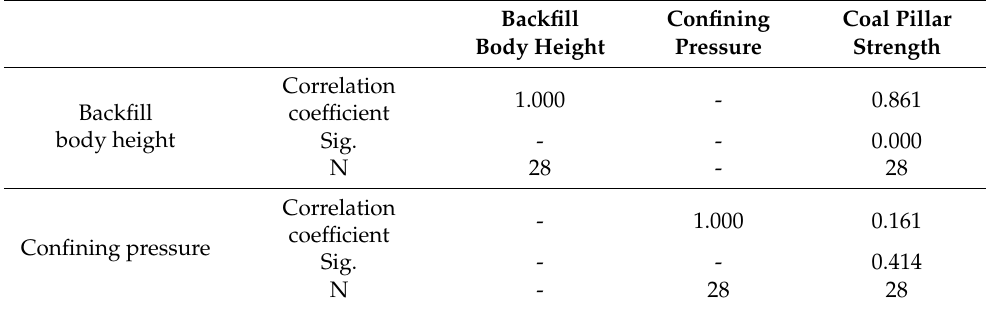
Table 6. Spearman’s rank correlation coefficient.